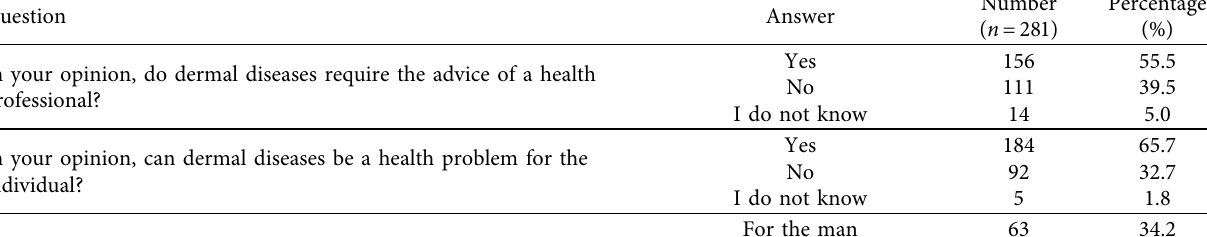
Table 3: Citizens’ views on skin